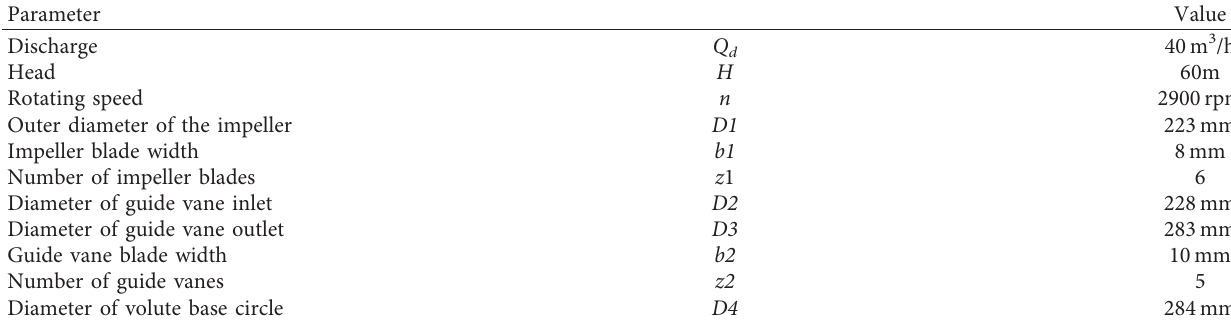
Table 1: The main parameters of centrifugal